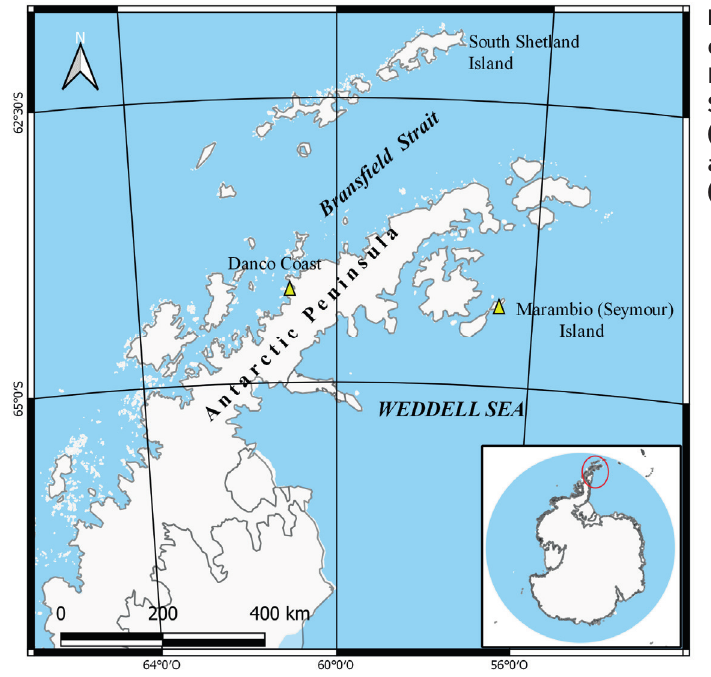
Figure 1. General view of Antarctica.